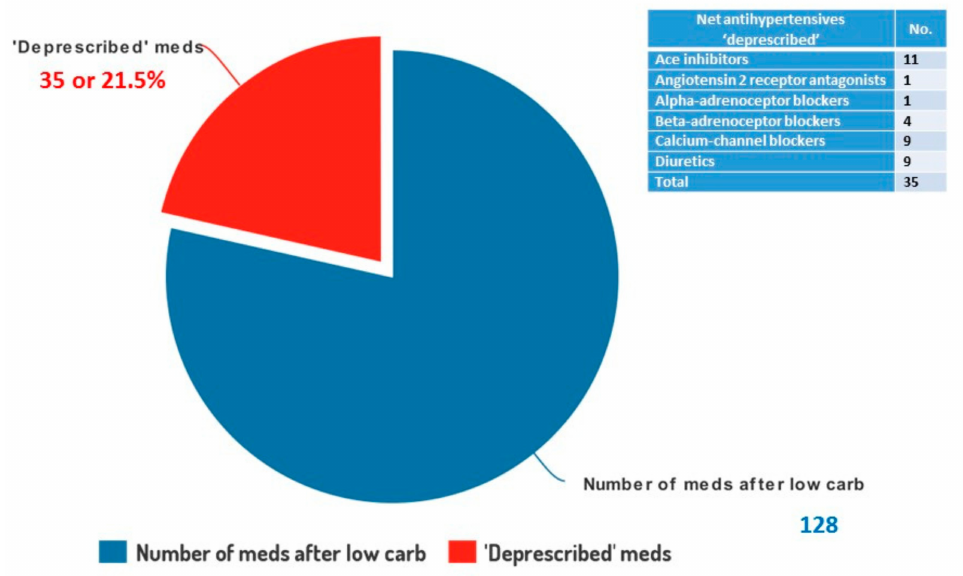
Figure 5. Pie chart to show the number of medications for hypertension deprescribed for the 154 patients on a low carbohydrate diet over an average of 24